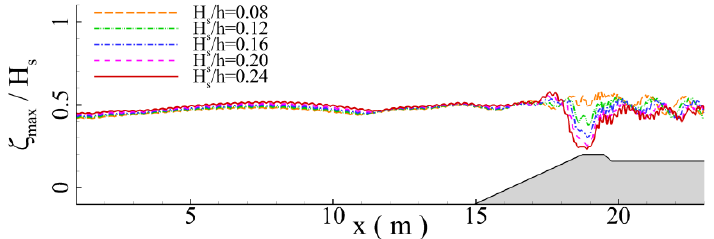
Figure 17. Space distributions of the local maximum water surface elevation.